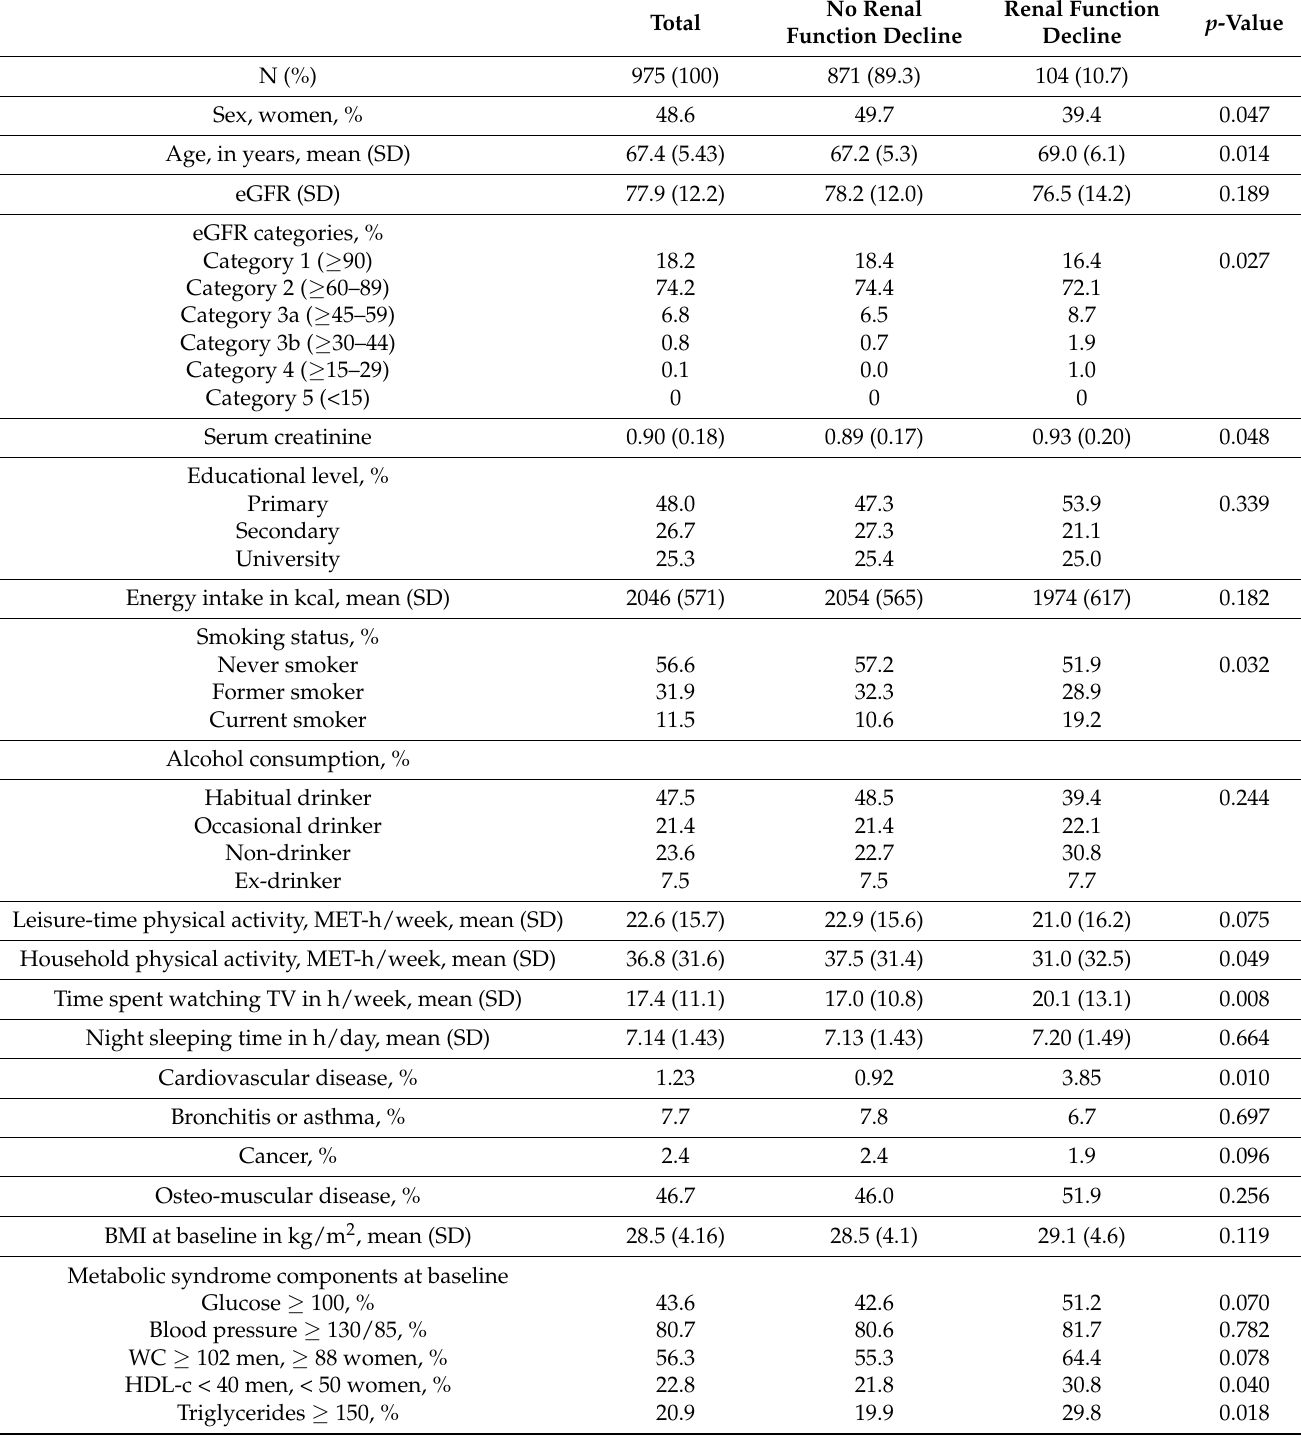
Table 1. Baseline characteristics of the Seniors-ENRICA participants according to renal